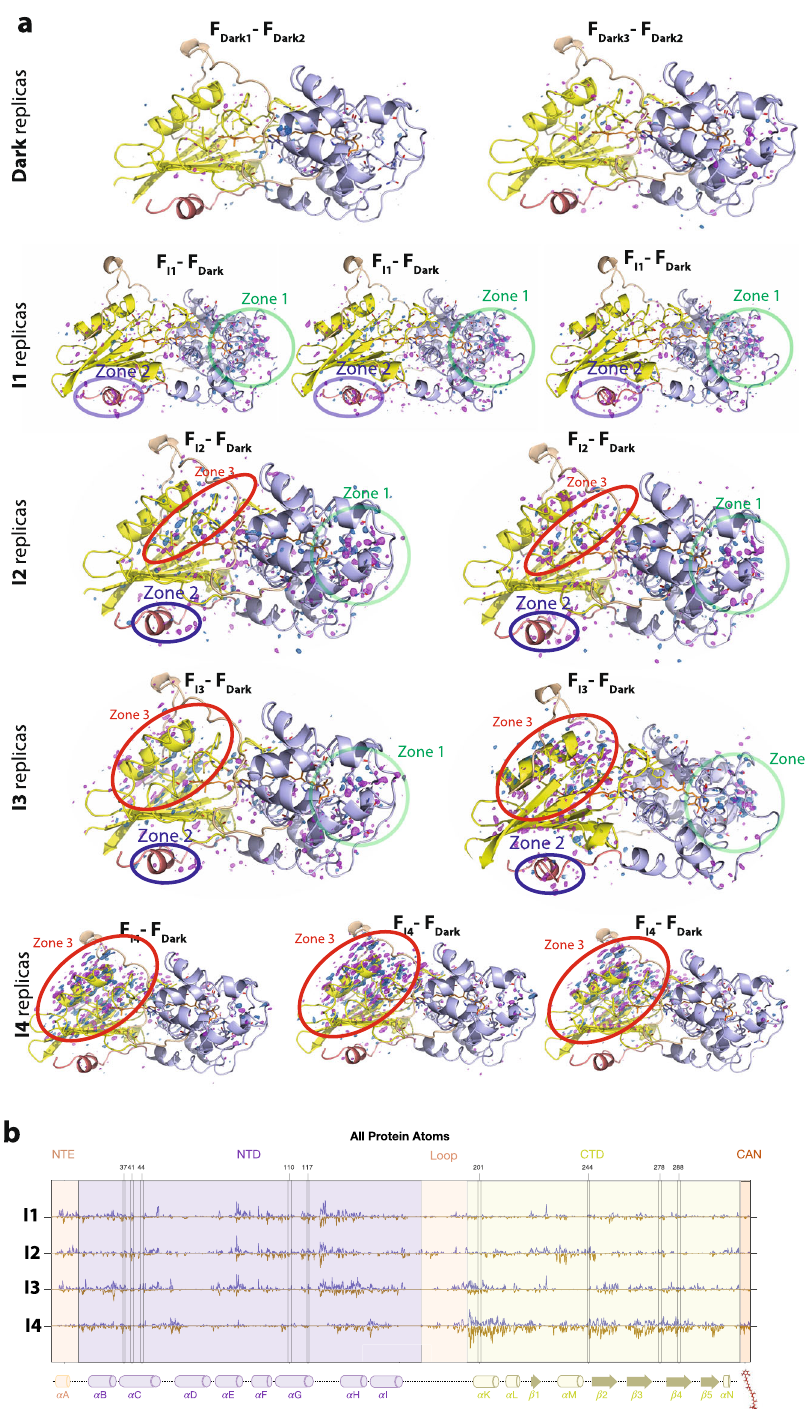
Fig. 3 | DED signals in different states. a DED maps contoured at ±3.5 σ (blue and magentacorrespondtotheappearanceanddisappearanceofdensity,contouredat 3.5 σ ). Dark state DED signals contoured at (±)3.5 σ . The F Dark1 – F Dark2 and F Dark3 – F Dark2 exhibit marginal DED signals. The F I1 – F Dark , F I2 – F Dark , F I3 – F Dark , and F I4 – F Dark datasets show reproducible strong DED signals in the three different